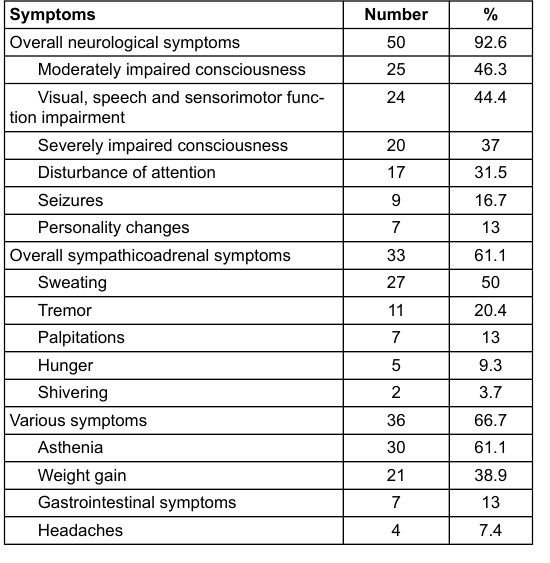
Table 3: Combination of symptoms at the time of diagnosis in 54 pa- tients with endogenous hyperinsulinaemic hypoglycaemia.